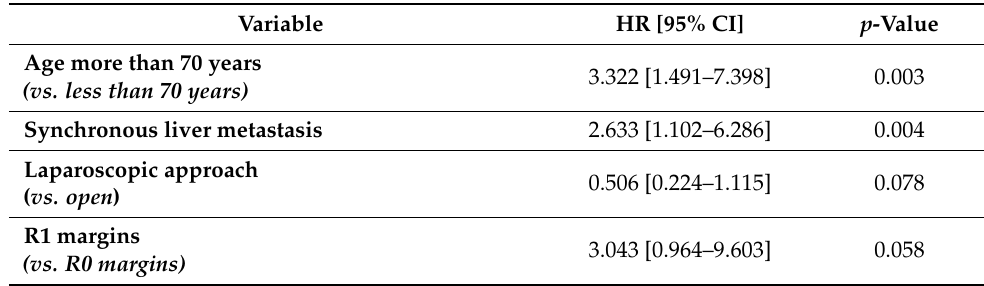
Figure 2. Overall survival of patients with T4 colorectal cancers. Table 5. Multivariate analysis of baseline characteristics and management plan for overall survival in patients with T4 colorectal